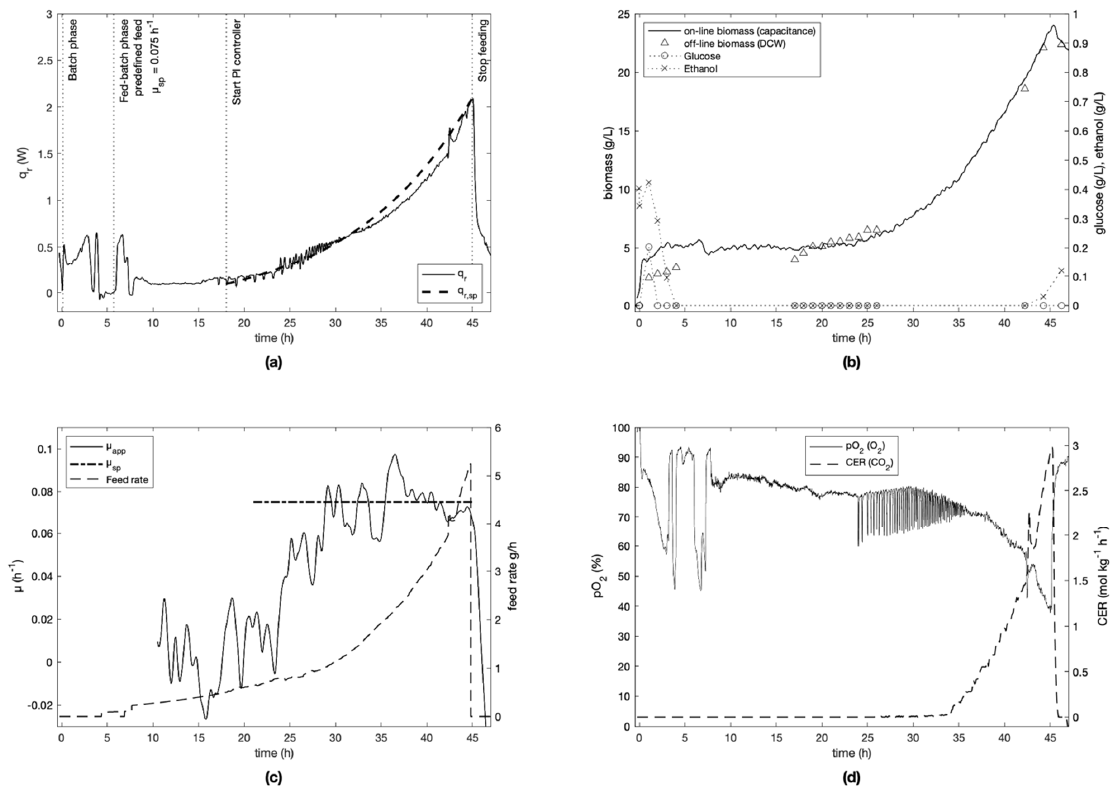
Figure 3. Fed-batch culture (E-1) of S. cerevisiae with µ sp of 0.075 h − 1 . ( a ) Heat flow (q r ) and dynamic heat flow setpoint (q r,sp ) profiles. Events indicated by vertical lines. ( b ) On-line (dielectric spectroscopy) and off-line (DCW) biomass. Glucose and ethanol concentrations measured by IR spectroscopy. ( c ) Apparent specific growth rate ( µ app ) from dielectric spectroscopy, specific growth rate setpoint ( µ sp ) and feed rate (F feed ) of glucose. Controller MRE of 13% achieved. ( d ) Oxygen partial pressure (pO 2 ) and carbon dioxide evolution rate (CER). Oscillations of pO 2 and q r signals start simultaneously with the addition of NaOH for the pH regulation.